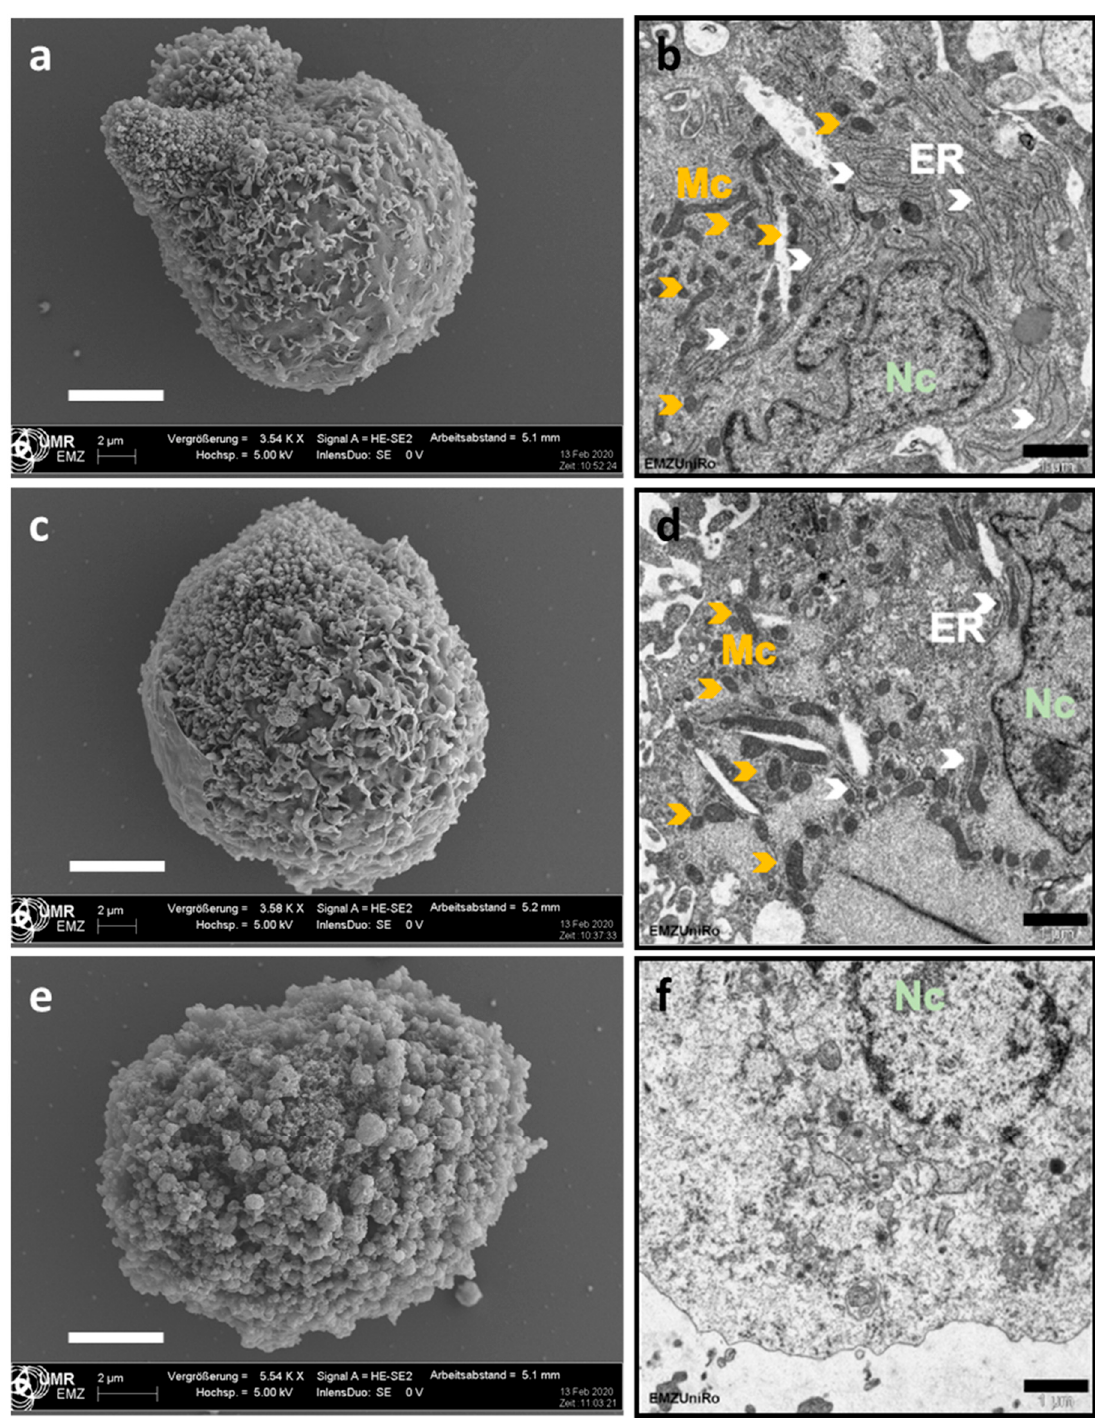
Figure 5. Cell structure analysis of human osteoblasts following HHP treatment. Treated cells ( c , d 150–200 MPa; e , f : 250–300 MPa) and untreated cells ( a , b ) were fixed to carry out field emission electron ( a , c , e scale bar: 5 µm) and transmission electron ( b , d , f ; scale bar: 1 µm) microscopy. Abbreviations: Nc = nucleus (light green), Mc = mitochondrion (orange), ER: endoplasmic reticulum (white).